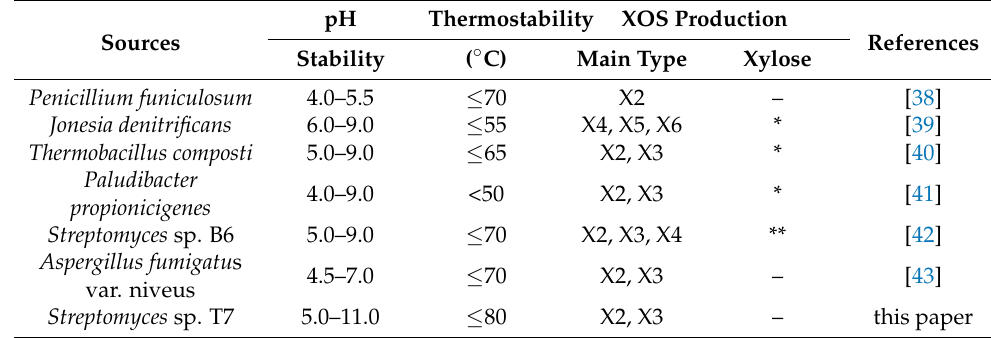
Figure 6. Effects of various factors on the production of XOS from corncob xylan via enzymatic hydrolysis. The factors are as follows: ( a ) time course; ( b ) enzyme dose (xylan, U/mL); ( c ) substrate concentration (corncob xylan, mg/mL); ( d ) temperature ( ◦ C). Table 3. Properties and XOS production of XynST7 and other GH10 xylanases.